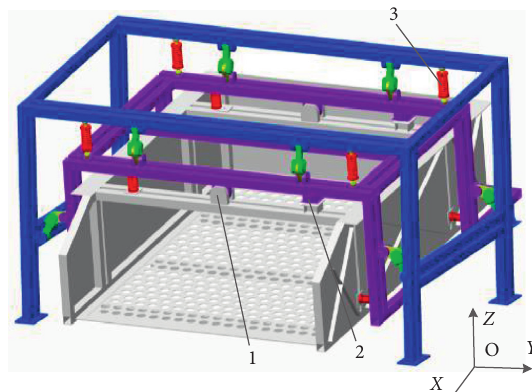
Figure 4: Dynamic principle. 1: revolving support device; 2: electromagnetic exciter; 3: suspension spring.